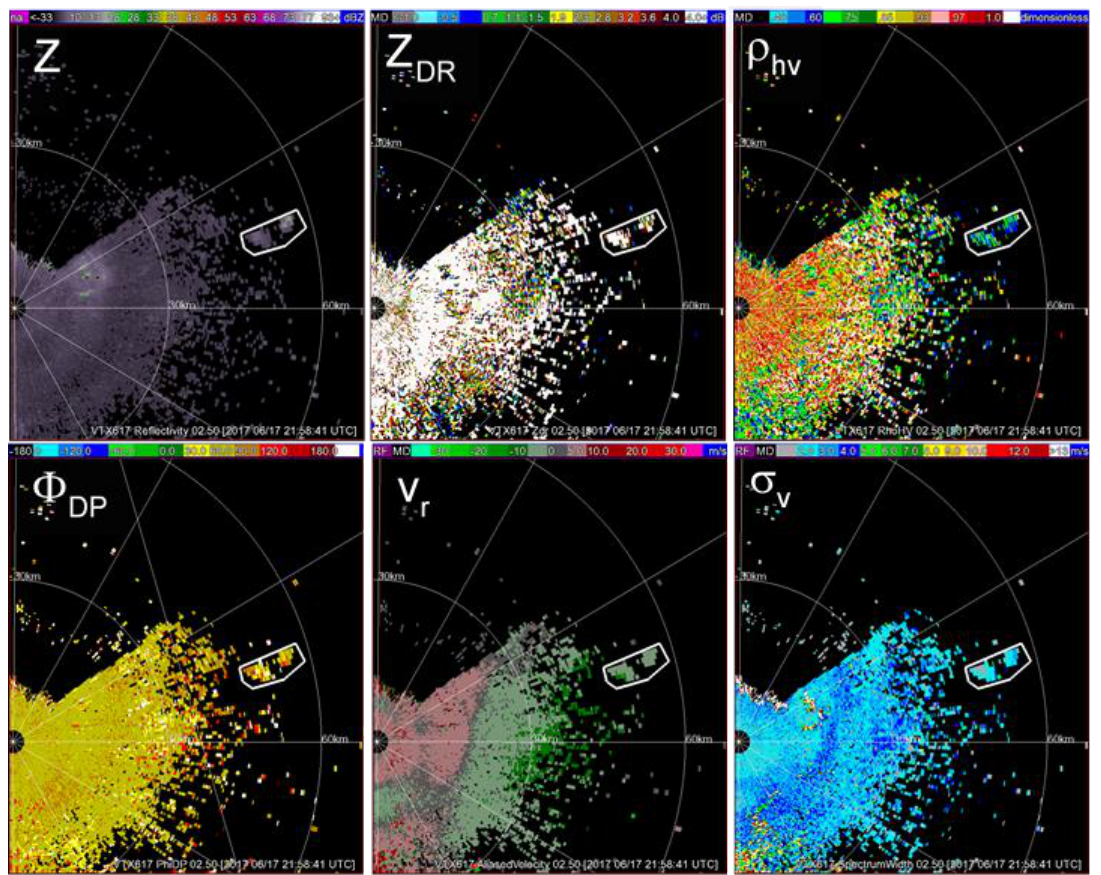
Figure 18. The fields of the polarimetric variables at the time of the brush fire near Castaic Lake, California, on June 17, 2017. The radar is a WSR-88D in Los Angeles (code designation KVTX). The polygon encircles the smoke plume, the elevation angle is 2.5 ◦ , the time is 21:58 UTC, and the range marks are at 30 and 60 km.